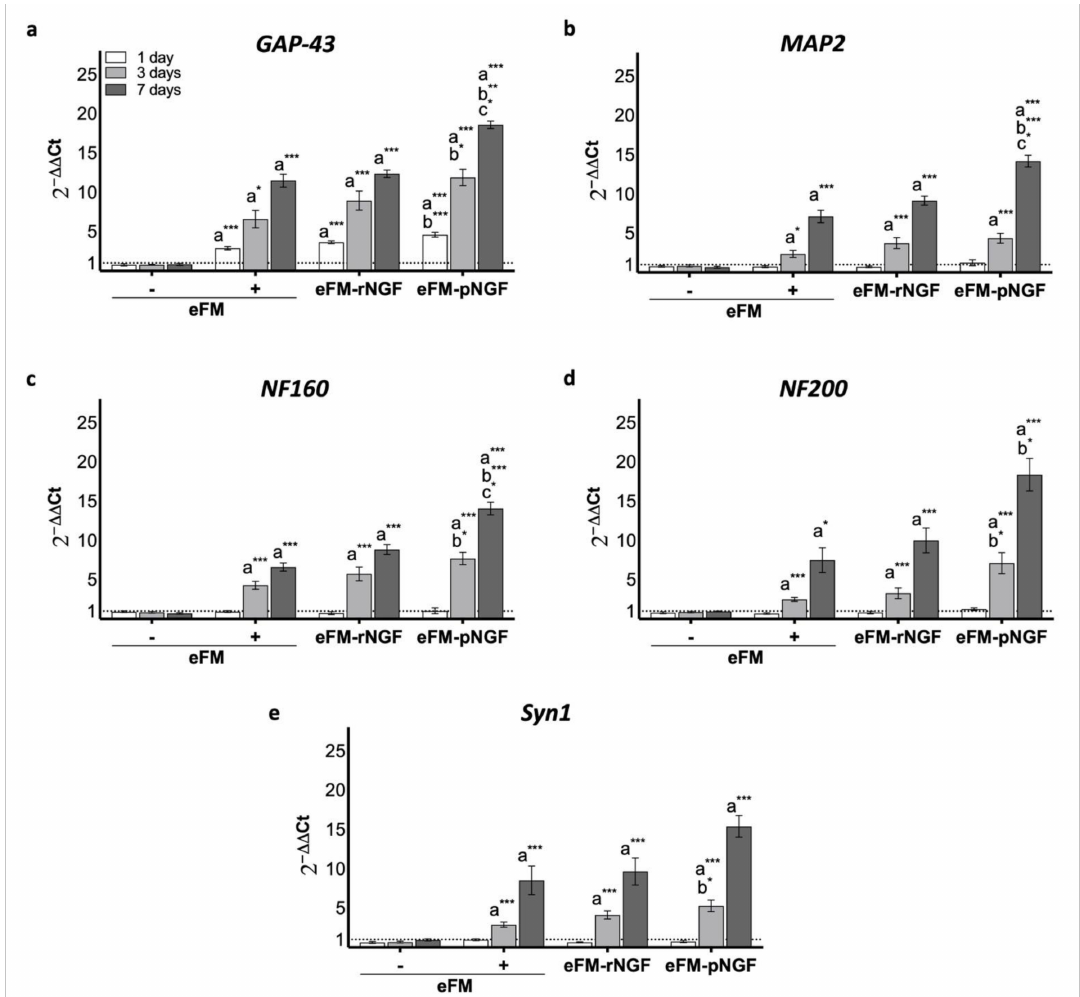
Figure 4. Relative expression of GAP-43 ( a ), MAP2 ( b ), NF160 ( c ), NF200 ( d ) and Syn1 ( e ) genes by PC12 cells cultured on the different culture condition, along culturing time. The expression was normalized against the GAPDH gene, being the quantification performed with the negative control (eFM − ) as calibrator, according to the Livak method. The one-way ANOVA with the Tukey’s HSD post hoc test were applied ( p < 0.01): a represents significant differences compared to eFM − ; b represents significant differences compared to eFM+, and c represents significant differences compared to eFM-rNGF; * p < 0.01; ** p < 0.001; *** p < 0.0001. After 7 days of culture, the PC12 cells were immunostained for GAP-43, NF200, and Syn1. Figure 5 demonstrated that NGF-stimulated differentiation of PC12 cells toward the neural cell phenotype in eFM+ condition was similar to, although a slightly lower than, the eFM-pNGF or eFM-rNGF conditions (Supplementary Figure S2). Furthermore, neuronal differentiation in both eFM-NGF systems was significantly higher than in the negative control condition (eFM − ). Collectively, these phenotypic results confirm the previously described genotypic